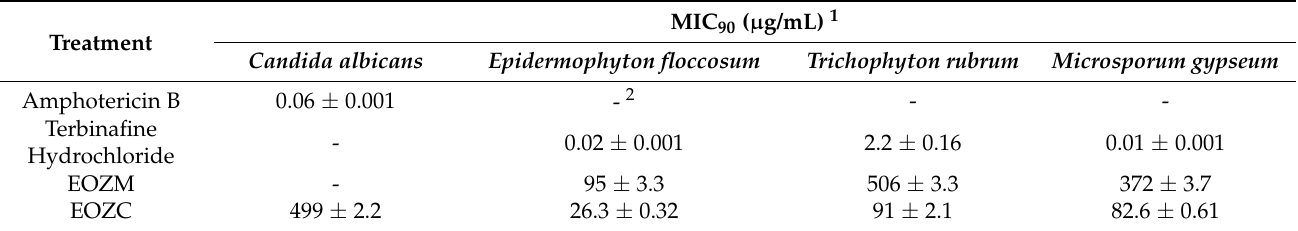
Table 2. Antifungal activity of essential oils from Z. acanthopodium fruits.